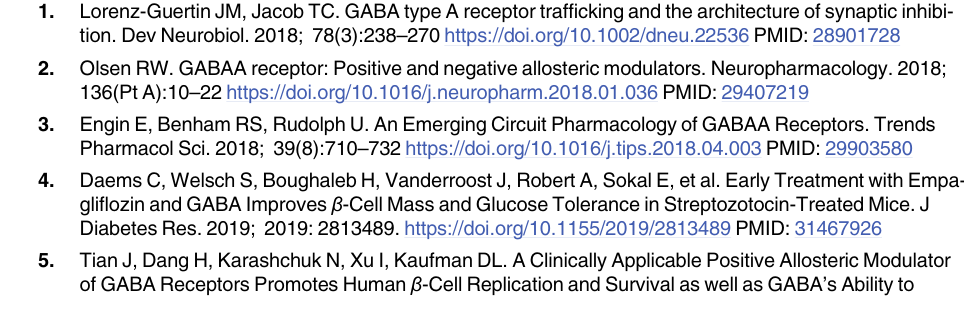
S1 Fig. Secondary only controls for Fig 1: Expression of GABA(A)R subunits in mouse and human T cells. A . Staining of mouse splenocytes with AlexaFluor647-conjugated goat anti- rabbit antibody (Red). Cells were counterstained with DAPI (blue). B . Staining of human PBMCs with AlexaFluor488-conjugated mouse anti-CD3 (green) and AlexaFluor647 conju- gated goat anti-rabbit antibody (Red). Cells were counterstained with DAPI (blue). Scale bars 10 μ